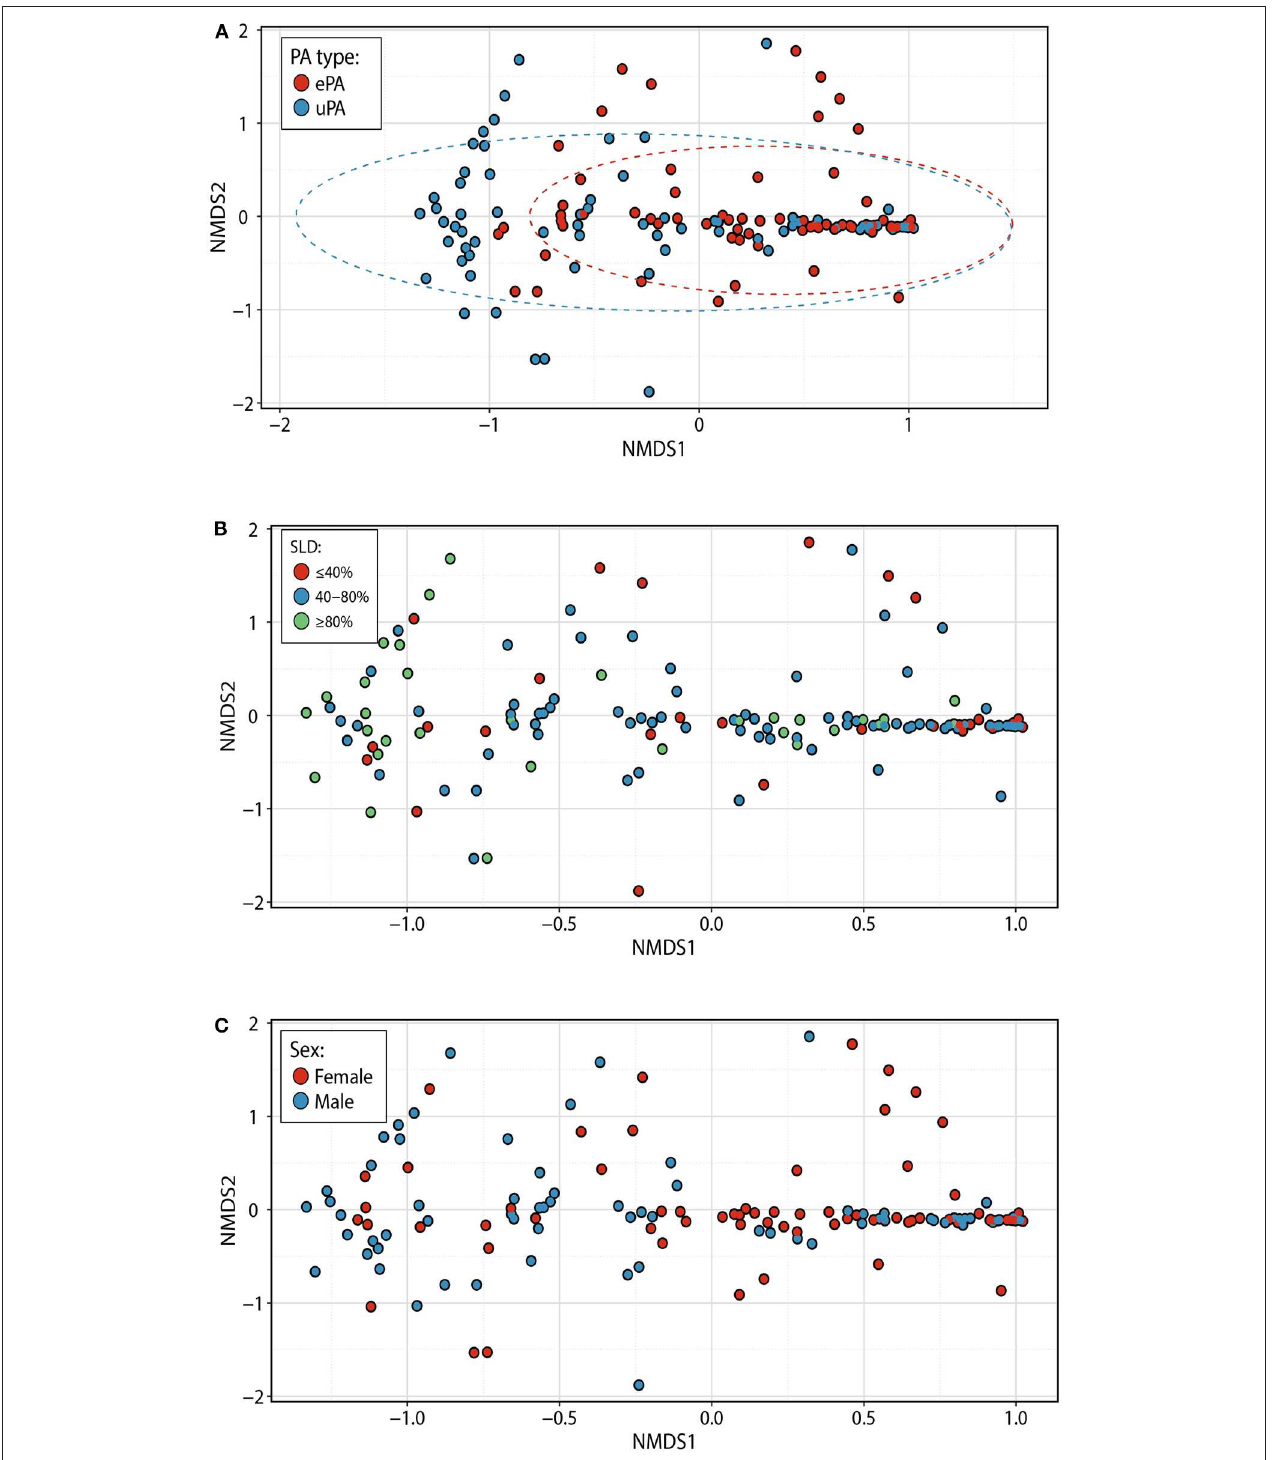
FIGURE 1 | Bacterial community structure within patients with epidemic and unique P. aeruginosa strains. NMDS plots based on Bray-Curtis distances among 144 samples (representing each point). Samples are colored based on PA typing [ePA (red) and uPA (blue)] (A) , the stage of lung disease at the sample collection [ < 40% (advanced), 40–80% (moderate), and > 80% (mild)] (B) , and gender [female (red) and male (blue)] (C) . Ellipses denote 95% confidence intervals. NMDS, non-metric multidimensional scaling, PA, P. aeruginosa ; ePA, Epidemic strains of PA; uPA, unique strain of PA; SLD, stage of lung disease.